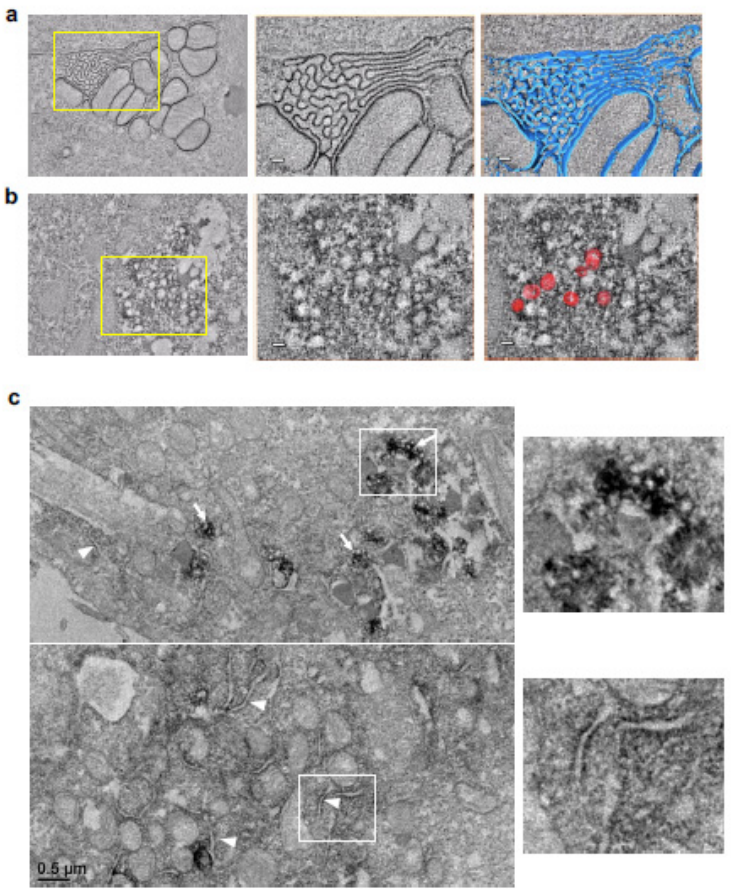
Figure 4. Electron tomography images of ( a ) APEX2-NHR and ( b ) APEX2-3A. The serial section was obtained from PK-15 cells expressing APEX2-NHR or APEX2-3A (full-length of 3A). The ER structures with DAB reaction products for APEX2-NHR (blue) were illustrated in the Amira/Avizo software, while eight vesicle-like structures with APEX2-3A were manually illustrated (red) as representative examples. ( c ) TEM images of APEX2-N2HRC1. White arrows indicate vesicle-like structures with APEX2-N2HRC1. In addition, segmented ER was found and marked by a DAB reaction (white arrowheads).